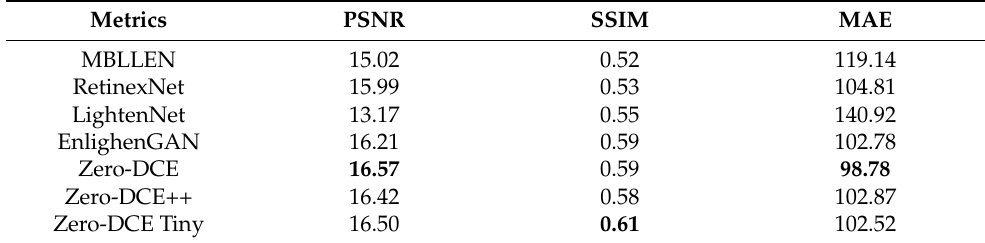
Table 3. Comparison of image enhancement